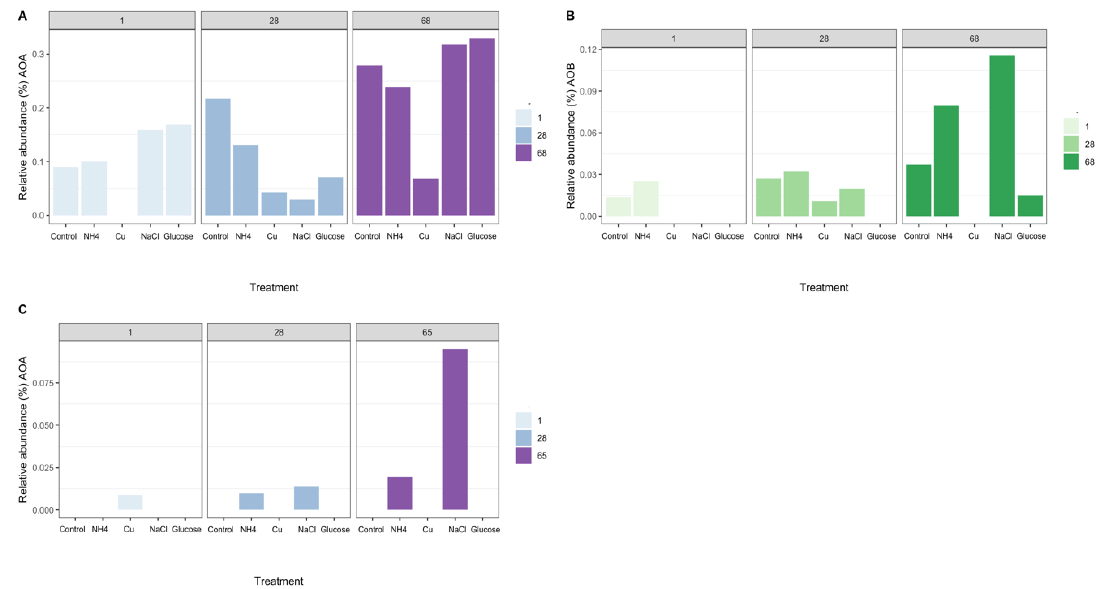
Figure 2. Relative abundance (%) of 16S rRNA transcript cDNA amplicons (Miers Valley— A and B ) and 16S rRNA gene PCR amplicons (Beacon Valley— C ) assigned to known nitrifying organisms over